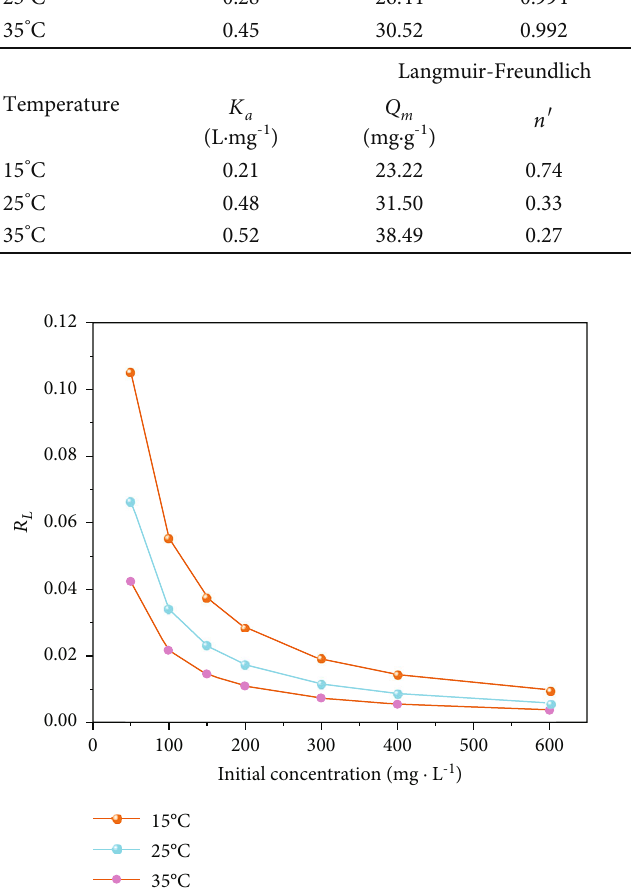
Figure 11: Separation parameters ( R L ) for Cu(II) adsorption by SP-SBC at di ff erent temperatures and initial Cu(II)